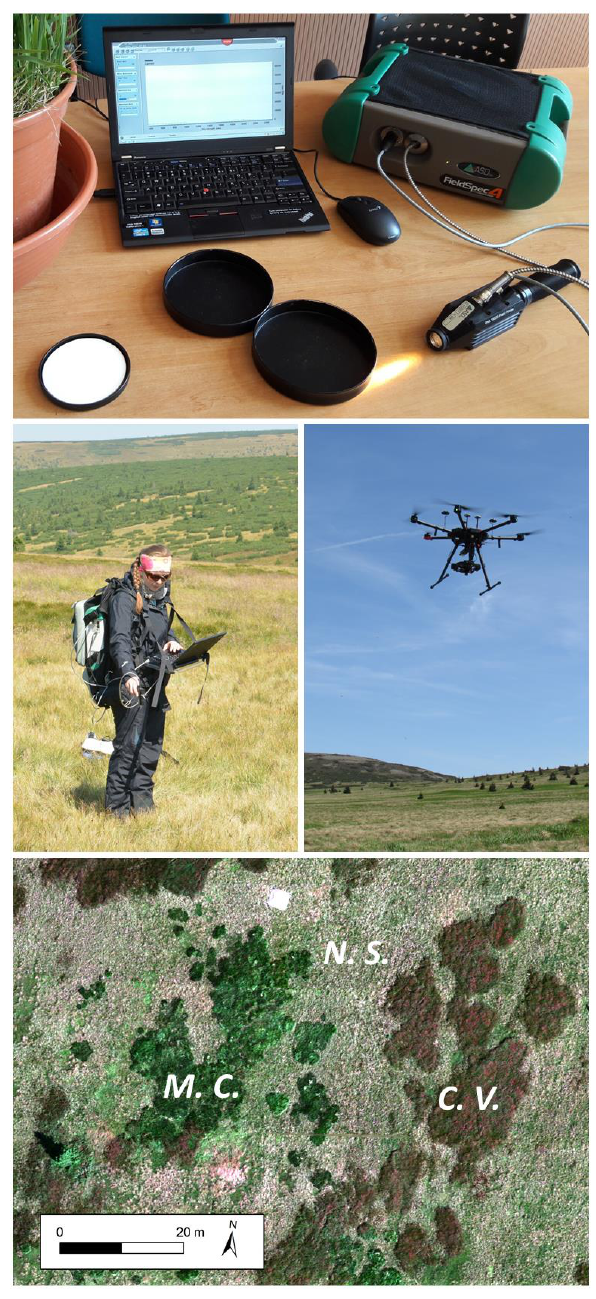
Figure 2. Instruments used to collect the spectral data: ASD FieldSpec4 Wide-Res coupled with a contact probe (up), the same spectroradiometer coupled with a pistol grip in a field (middle left) and Nano-Hyperspec® fastened to the DJI Matrice 600 Pro drone (middle right) with an example of the true colour composite of a part of the study area taken on 15 th August 2019, C. V. – Calamagrostis villosa; M. C. – Molinia caerulea, N. S. – Nardus stricta (bottom) The geometric corrections were performed in the Headwall SpectralView - Hyperspec v3.1.0 and ArcGIS for desktop software. The manual addition of tie points and developing our own script to mosaic the data in ArcGIS for desktop were necessary to reach acceptable root mean square error (RMSE) on ground control points (RMSE about 0.1 m). To